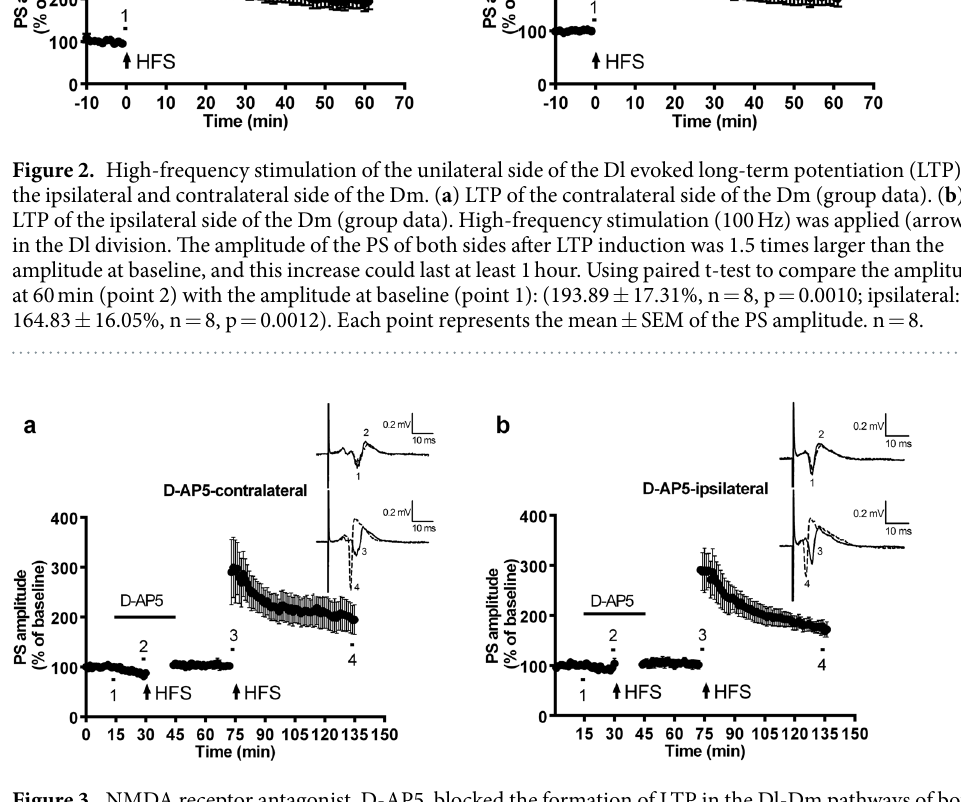
Figure 3. NMDA receptor antagonist, D-AP5, blocked the formation of LTP in the Dl-Dm pathways of both the contralateral and ipsilateral side. ( a ) Effect of D-AP5 on LTP induction in the contralateral side with Dm induction (group data). ( b ) Effect of D-AP5 on LTP induction in the ipsilateral side with Dm induction (group data). Here, 30 µ M of D-AP5 (solid line) was applied after 10 min of baseline recording. The first HFS (arrow) was delivered 15 min after the start of drug perfusion (point 2 compared to point 1, contralateral: 87.57 ± 3.97%, n = 9, p = 0.0576; ipsilateral: 104.3 ± 9.93%, n = 9, p = 0.9529). The second HFS (arrow) was delivered 30